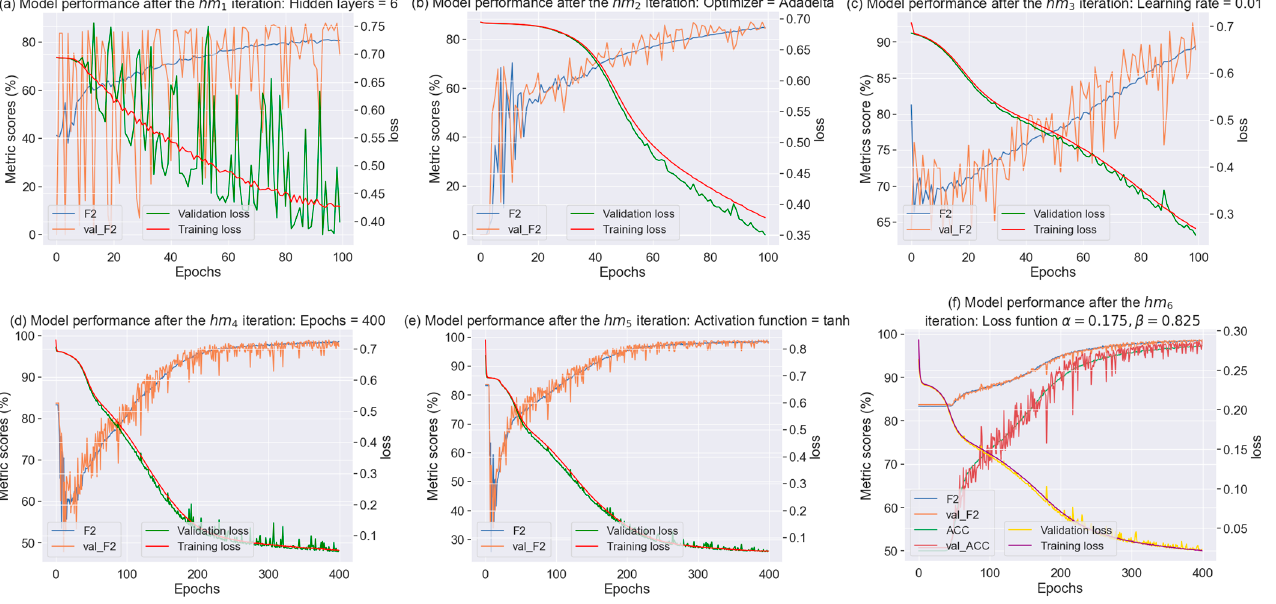
Figure 13. Summary of the proposed tuning methodology.